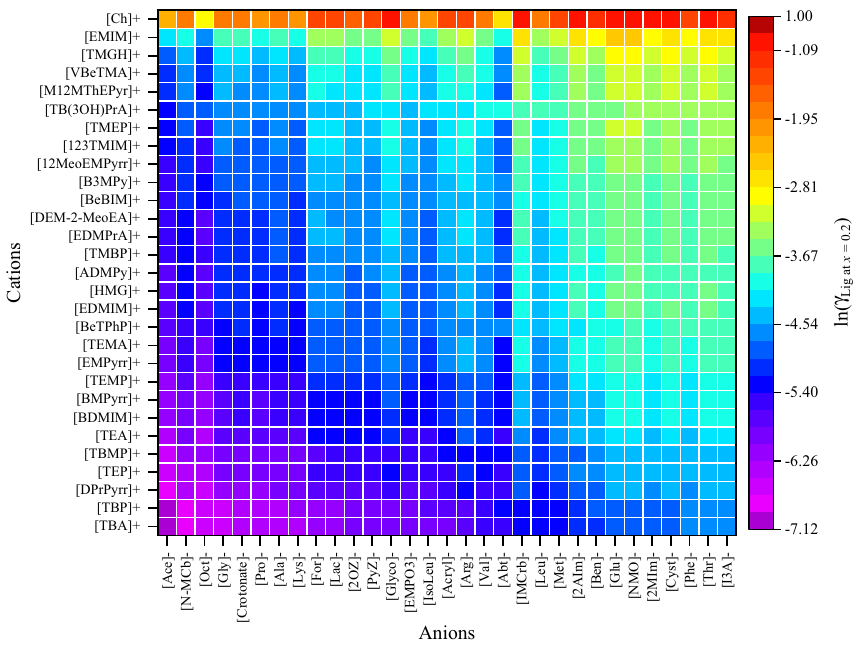
Figure 2. Graphical representation of the logarithmic activity coefficients (ln( γ )) of lignin in different ILs at 363.15 K by the COSMO-RS model. Origin2020 SR1 used to draw the heatmaps (https:// www. origi nlab. com/ 2020).